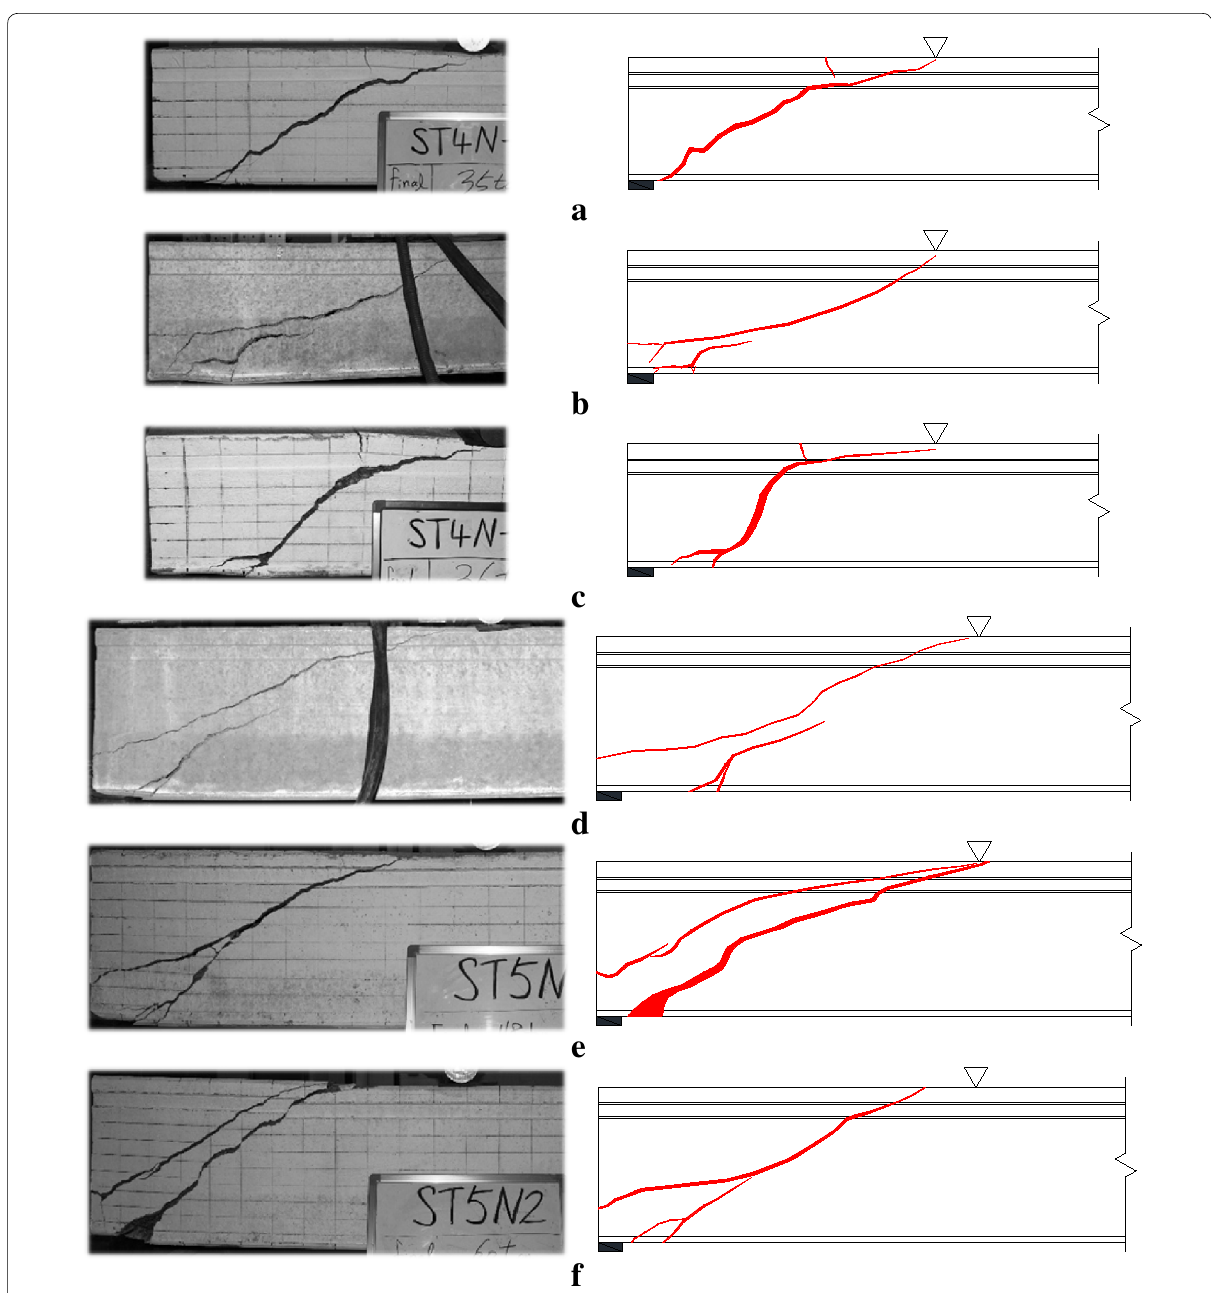
Fig. 7 Failure modes and crack patterns of specimens series S4 and S5. a Specimen S4‑1, b specimen S4‑2, c specimen S4‑3, d specimen S5‑1, e specimen S5‑2, f specimen